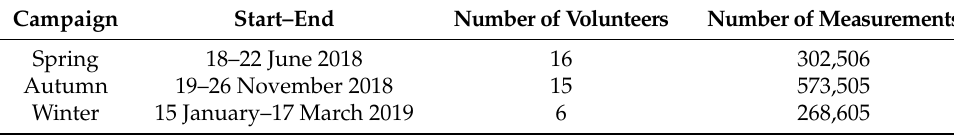
Table 1. Overview information on the three campaigns (time step = 1 min). Campaign Start–End Number of Volunteers Number of